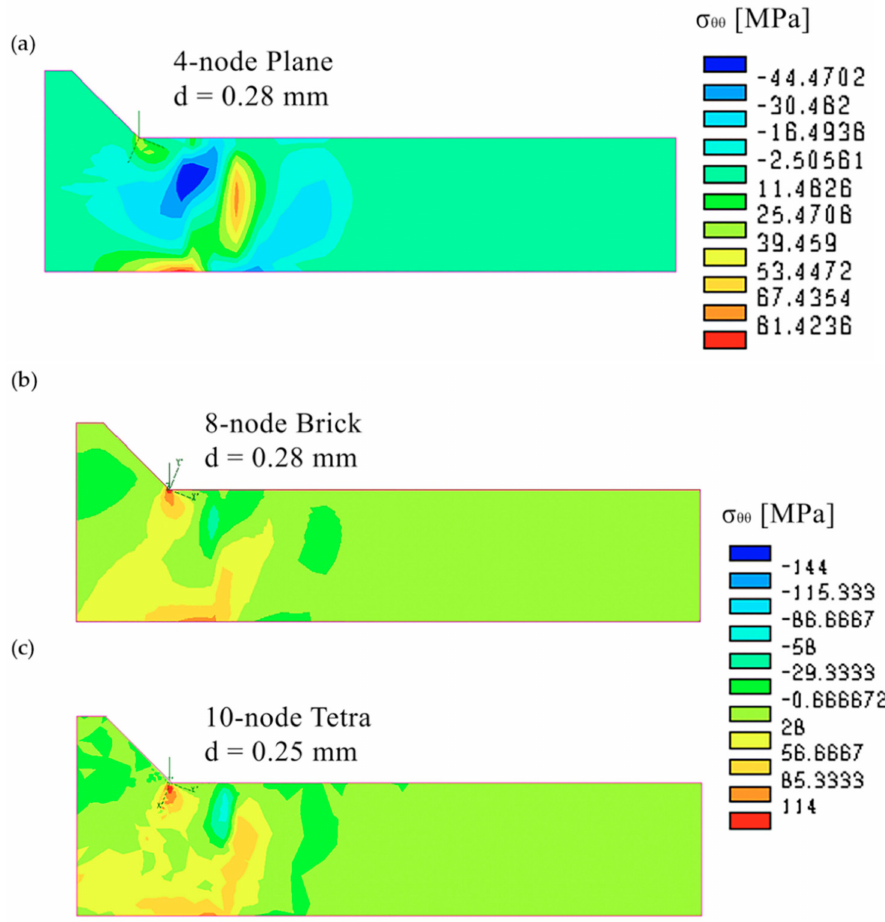
Figure 8. Comparison between the residual stress plots of the σ θθ component calculated by FE models with coarse meshes of ( a ) 2D 4-plane elements, ( b ) 3D 8-node brick elements, and ( c ) 3D 10-node tetra elements. For the 3D models, the plots refer to the half-width longitudinal